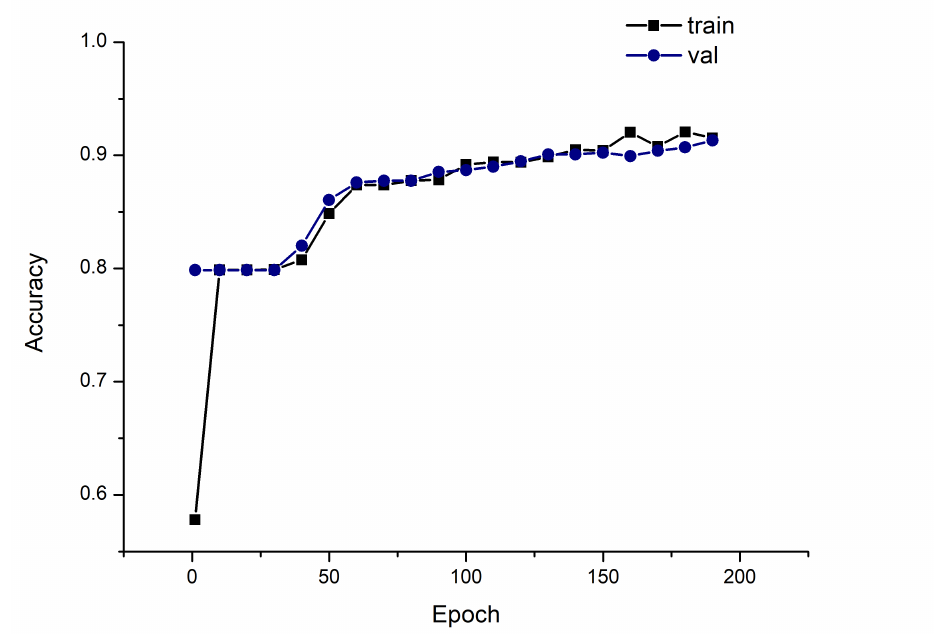
Figure 5. Classification accuracy of Text GCN model on the training set and validation set of certificates. As the line graph shows, Cert GCN is 8% more accurate than Text GCN at the point at